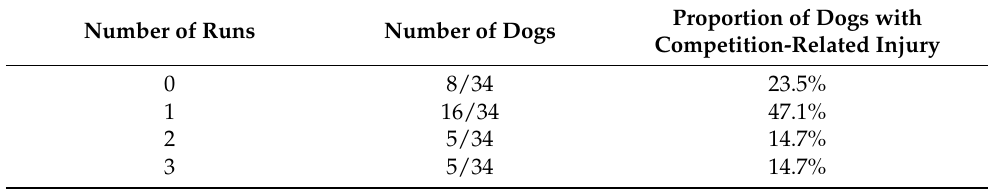
Table 2. Number of completed runs prior to competition-related injury ( n = 34).